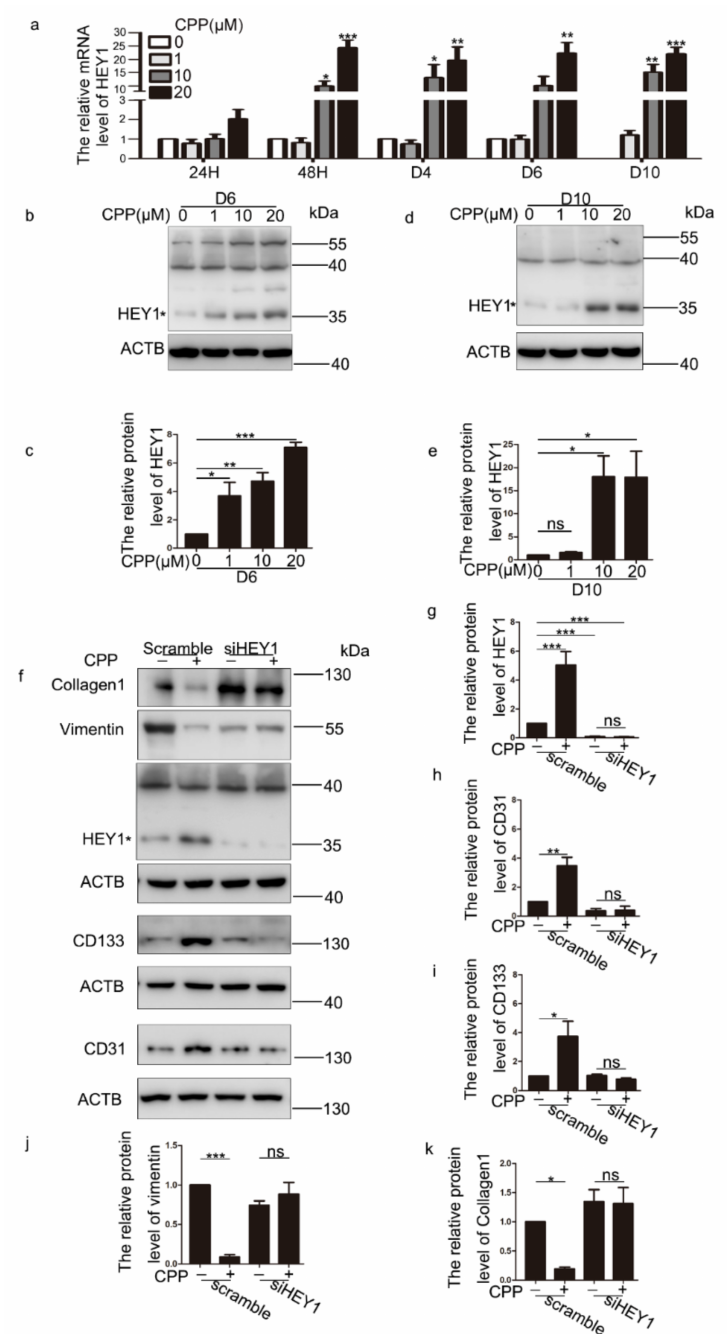
Figure 7. CPP induces the differentiation of HDFs into vascular endothelial-like cells by promot- ing the expression of HEY1. ( a – e ) HDFs were treated with CPP (0, 1, 10 or 20 µ M) for 24 h, 48 h, 4 days (D4), 6 days (D6) and 10 days (D10), respectively, then qPCR and Western blot were conducted to verify the expression of HEY1. ( f – k ) After knocking down HEY1 (siHEY1-1: 40 nM), HDFs were treated with CPP (10 µ M) for 6 days, and Western blot was used to detect the protein levels of HEY1 (33 kDa), CD31, CD133, Collagen 1 and Vimentin. Higher-molecular weight bands may represent post-translationally modified HEY1 proteins. β -actin (ACTB) was used as a loading control. Data are presented as means ± SEM, * p < 0.05, ** p < 0.01, *** p < 0.001, n =